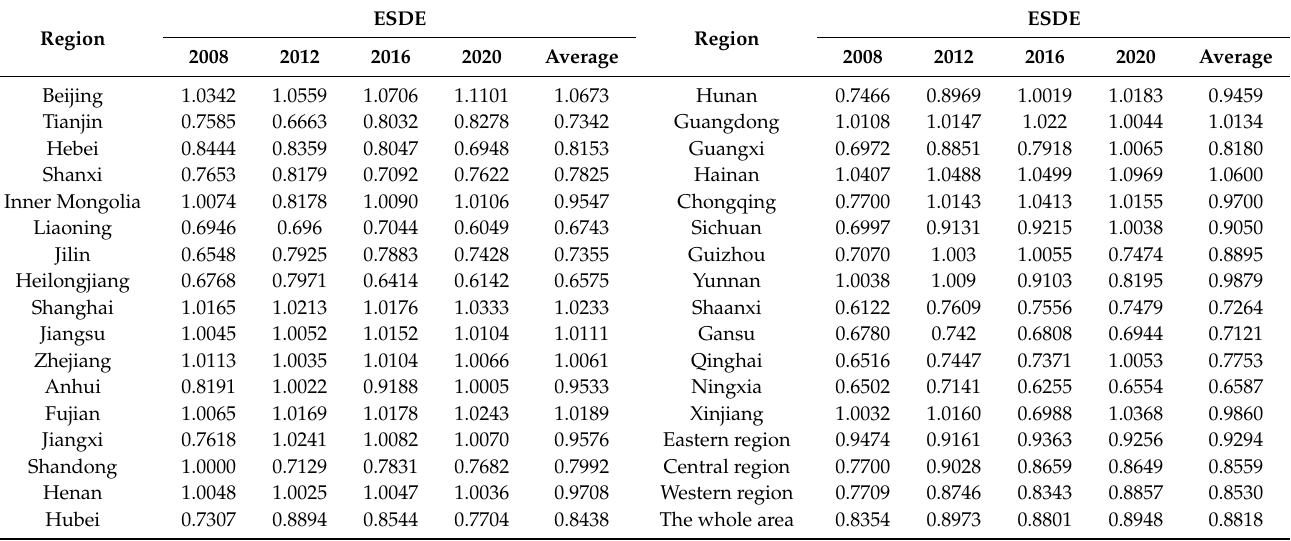
Table 2. The ESDE of China’s 30 provinces from 2008 to 2020. ESDE Region